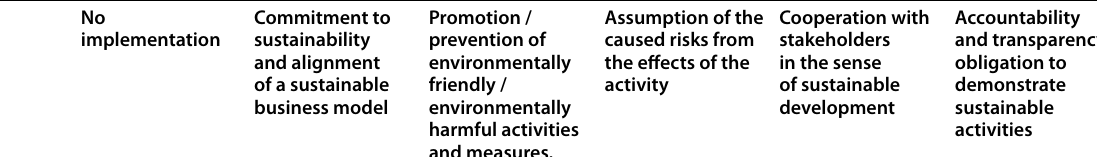
Table 5 Assignment of the strategic levels according to the key